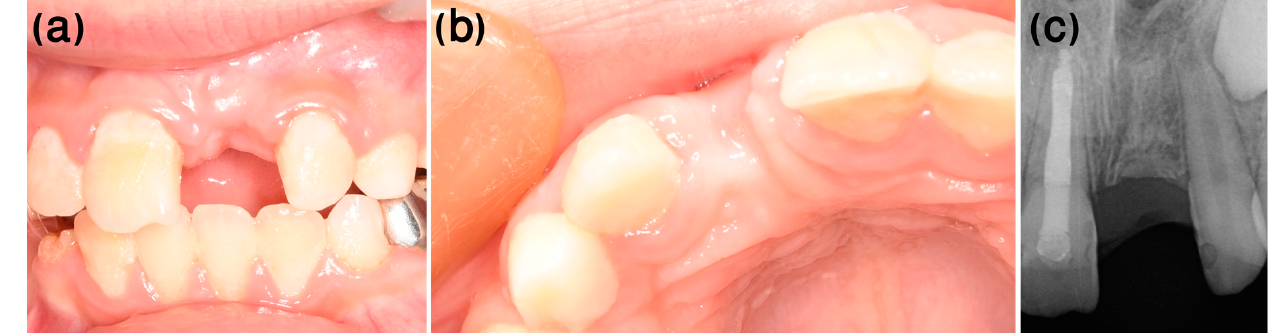
Figure 7. Case 1, six-month post-surgery follow-up. ( a , b ) Ridge dimensions can be noted, as well as ( c ) the radiographic appearance of bone apposition coronal to the resected root and replacement resorption progression.